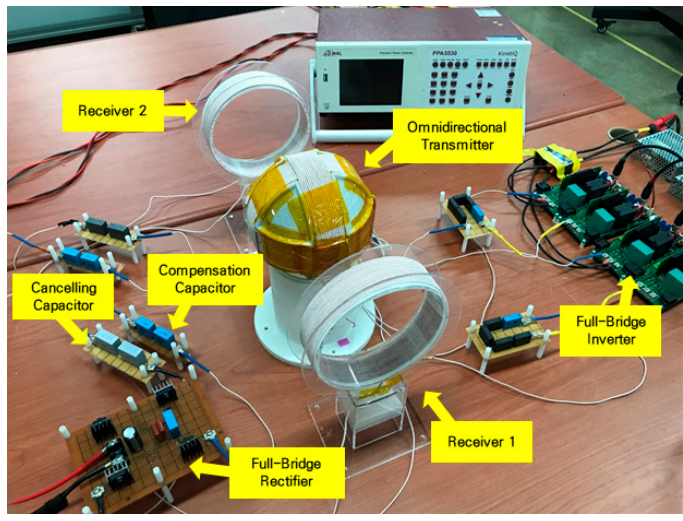
Figure 12. Experimental configuration.